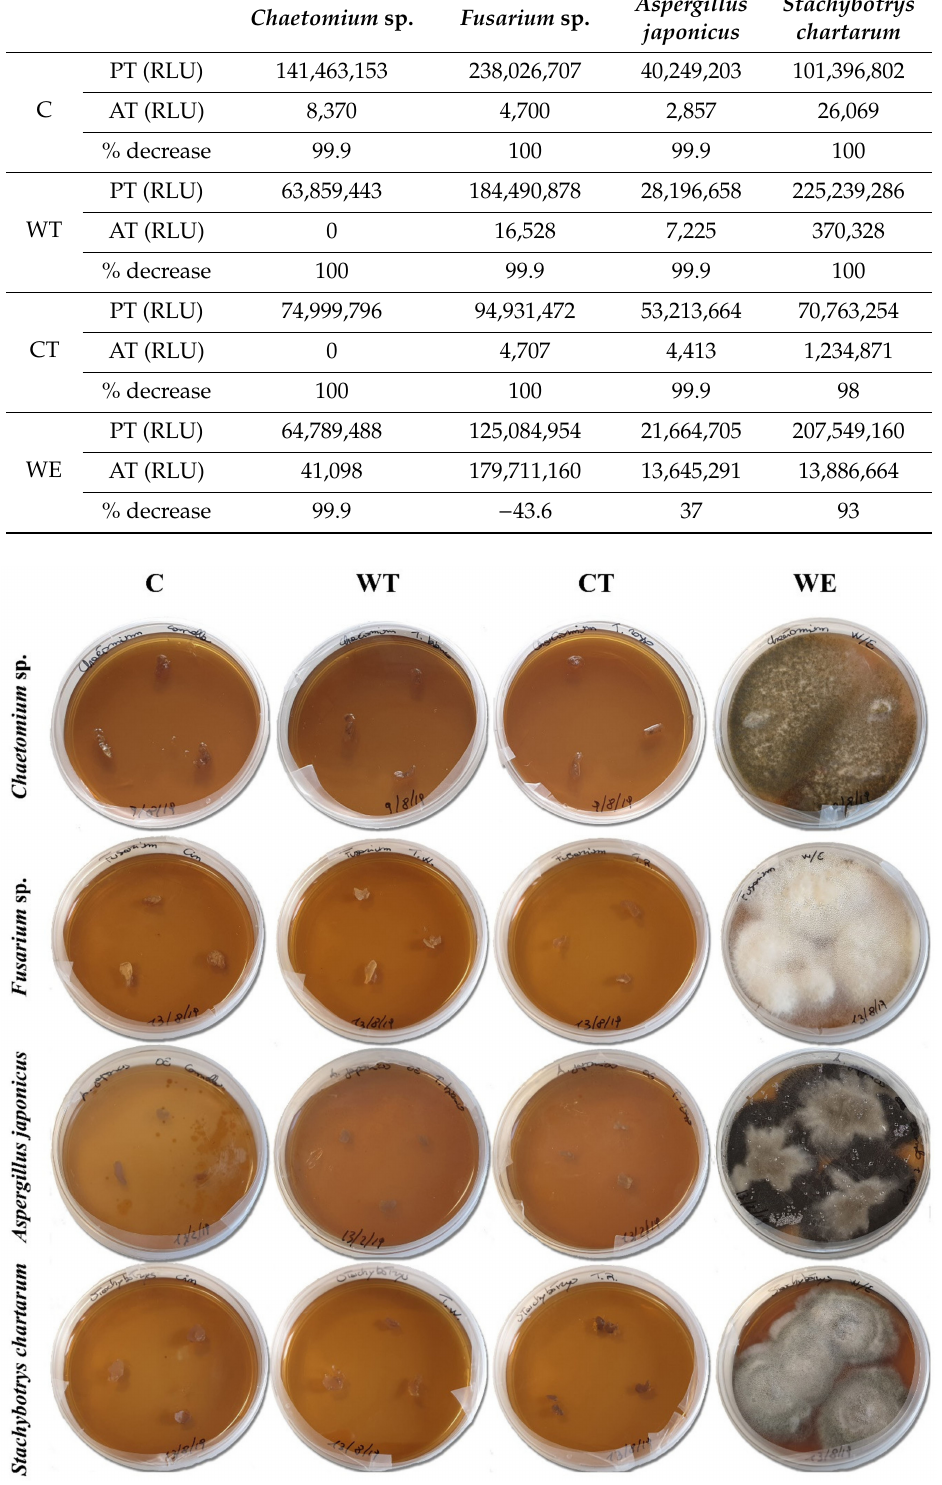
Figure 1. Results of cultural tests carried out on the fungal mycelia treated with the EOs MIC. (C: cinnamon; WT: wild thyme; CT: common thyme; WE: